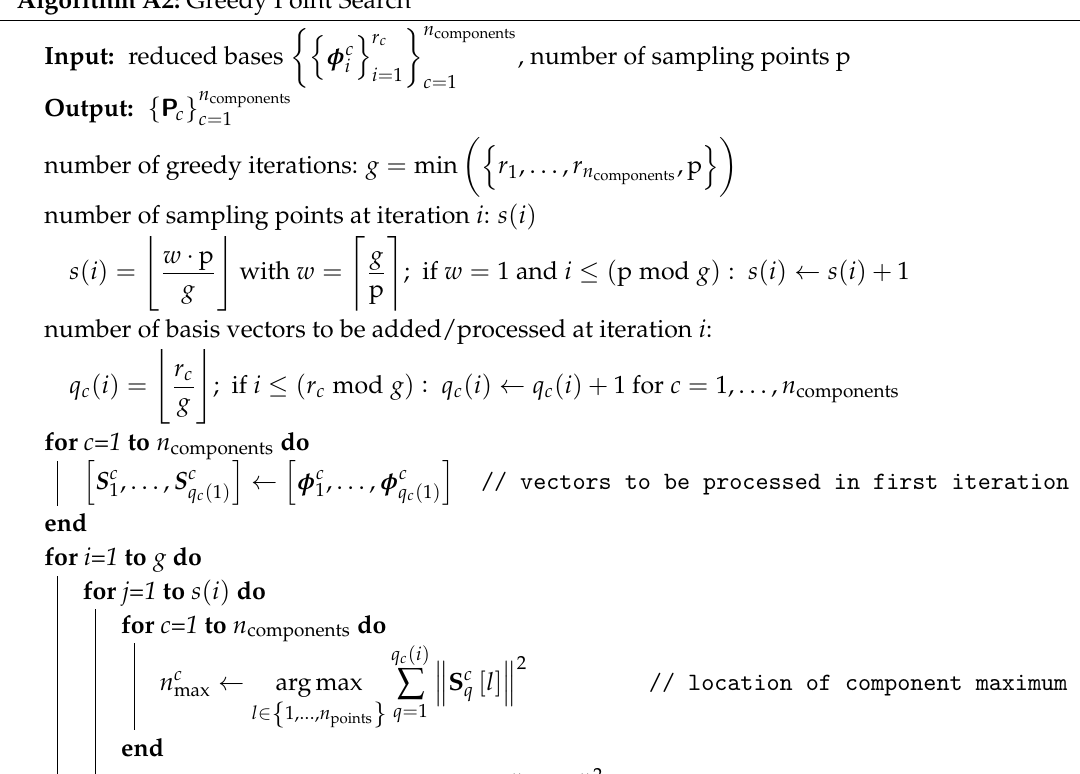
Algorithm A2: Greedy Point